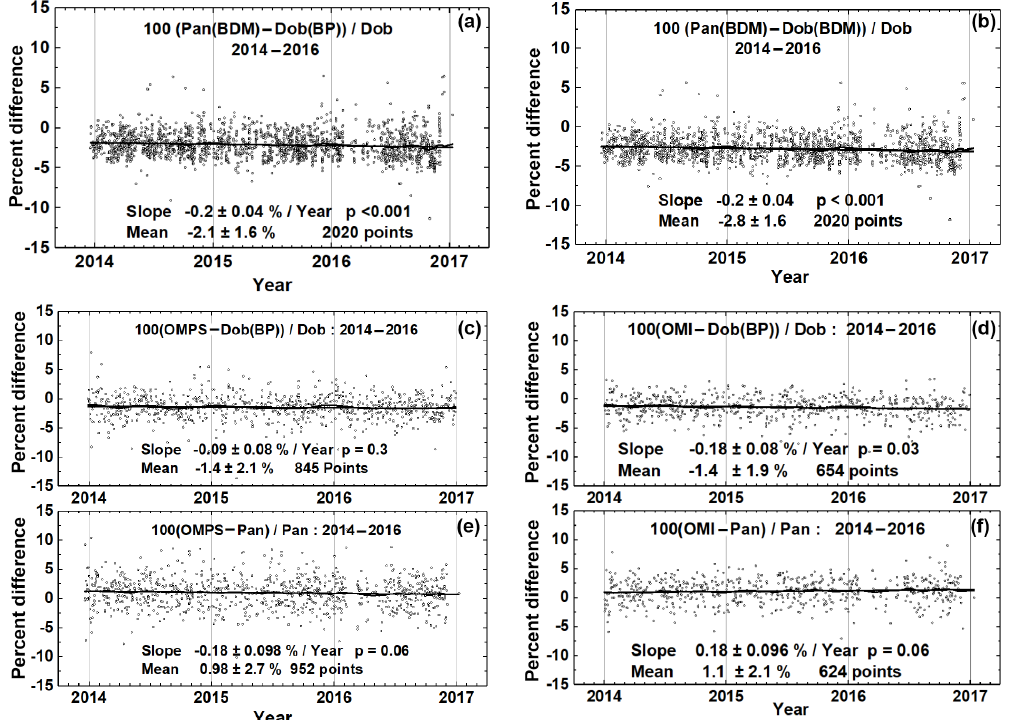
Figure 3. Comparisons of Pandora (BDM) with Dobson (BP and BDM) retrieved ozone for Boulder, Colorado, in percent differences of retrieved ozone and comparisons with OMI and OMPS. Slope is the value of the linear least-squares fit, ± N is 1SD, and p is the probability (0 to 1) that the slope is statistically different from 0 relative to p = 0.05. The solid lines are a Lowess (0.1) fit and a linear least-squares